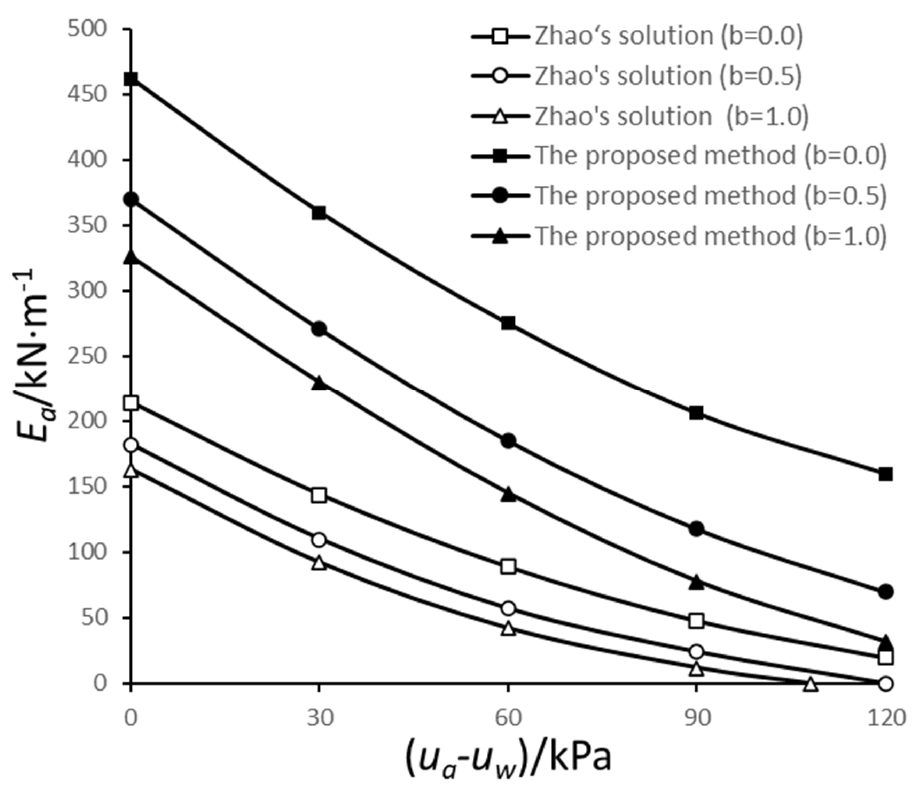
Figure 6. Comparative research of unsaturated soil.